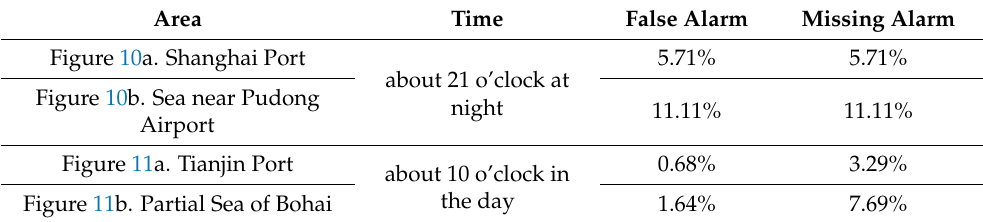
Table 8. Ship detection results for different scenarios and times. Area Figure 10a. Shanghai Port Figure 10b. Sea near Pudong Airport Figure 11a. Tianjin Port Figure 11b. Partial Sea of Bohai